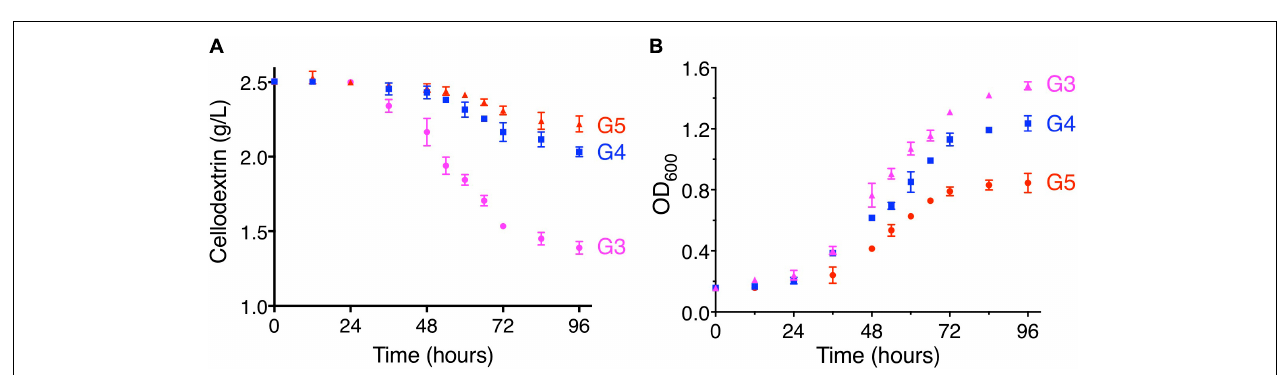
FIGURE 4 | The consumption of cellodextrins (A) and cell growth (B) of the YP β G-CtA strain. The yeast strain was cultured in the SM-Leu-Ura medium containing 0.25% (w/v) of cellotriose (G3), cellotetraose (G4), or cellopentaose (G5) as the sole carbon source at 30 ◦ C and 250 rpm.